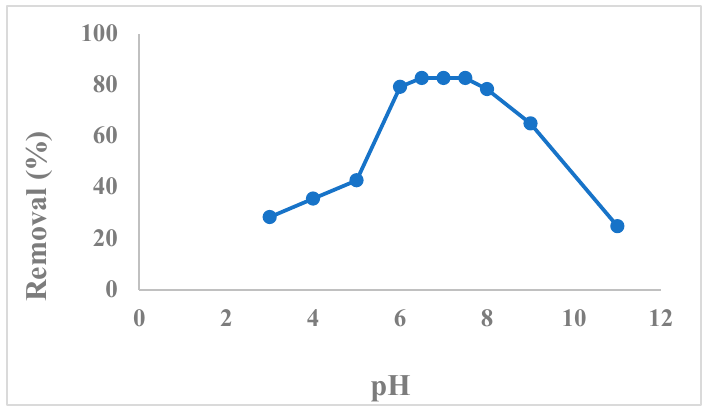
Figure 4. Effect of pH on the removal of CTM.